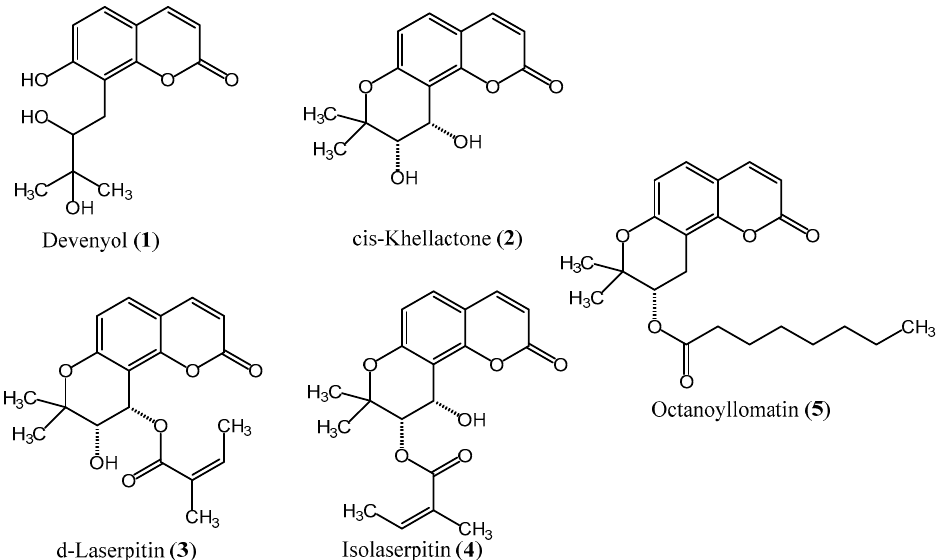
Figure 1. Chemical structures of isolated coumarins.